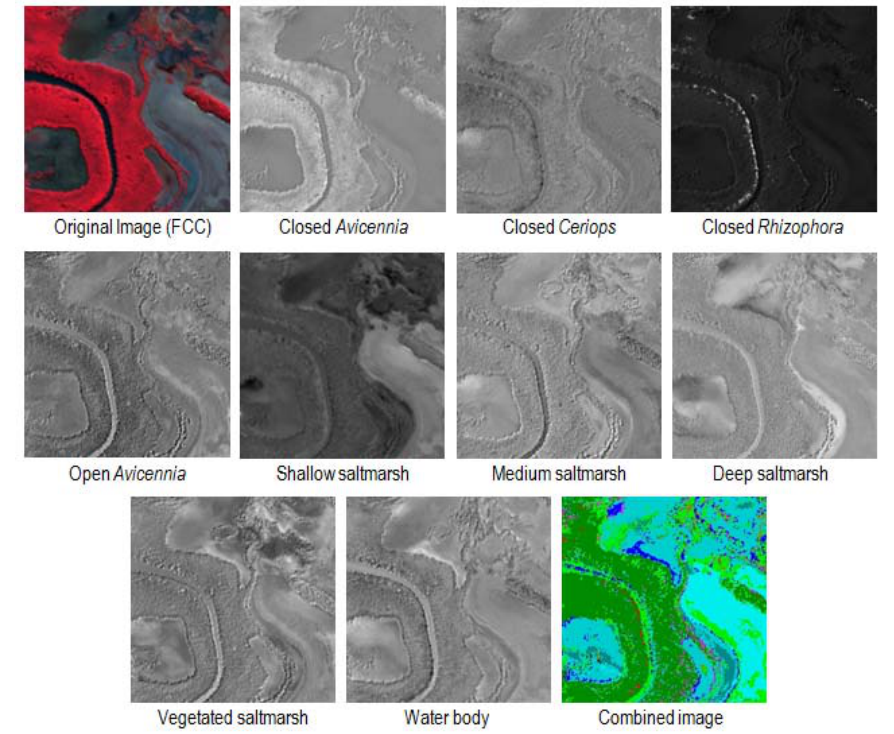
Figure 9. Linear spectral unmixing (LSU) images of each class and combined classification result. The greyscale images show the objects abundance or fractional cover of a pixel, brighter pixel represents higher abundance or fractional cover. The final combined classification image was produced after applying thresholds to each individual abundance/fraction image. See Figure 7 for classes’ legend to interpret the combined classified